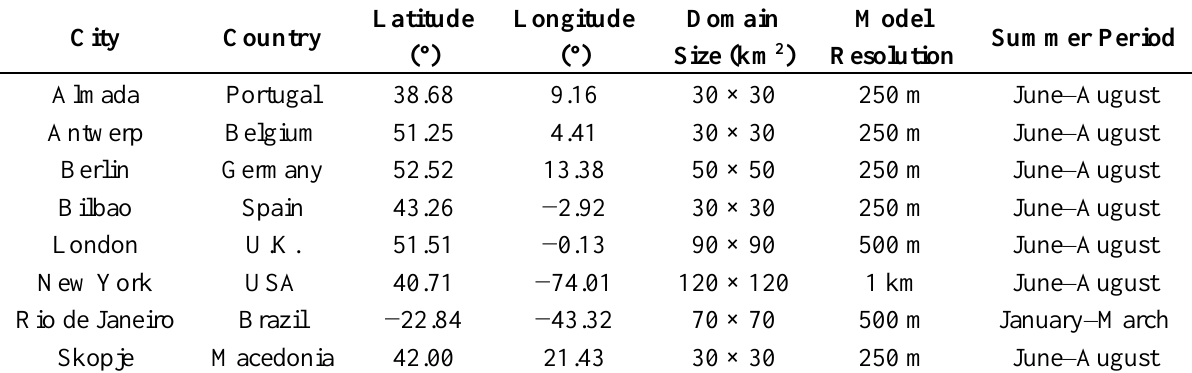
Table 1. Specifications of the cities, domains and periods considered